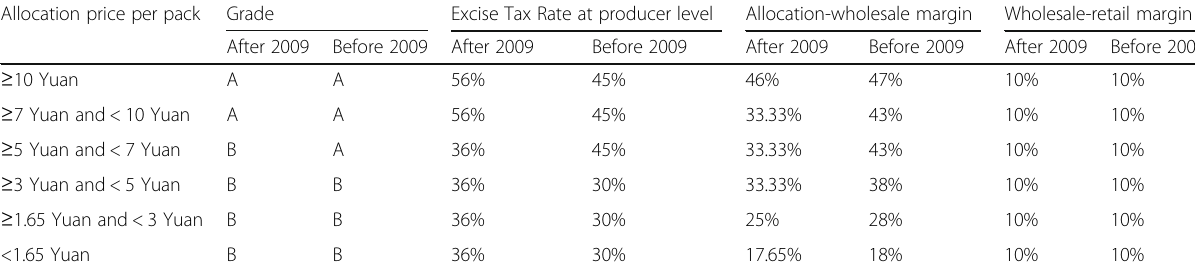
Table 1 Cigarette Classification and Profit